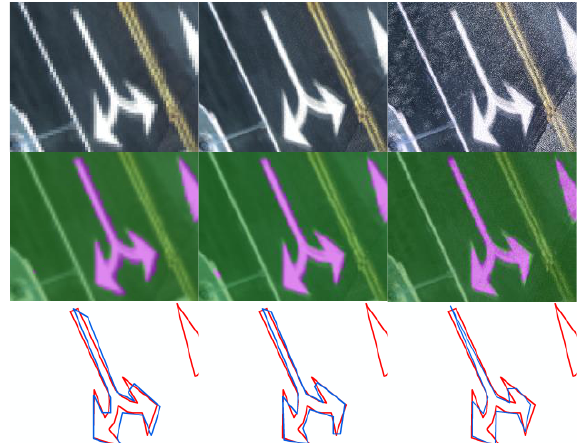
Figure 21. Sample arrow #3 – turn left or right